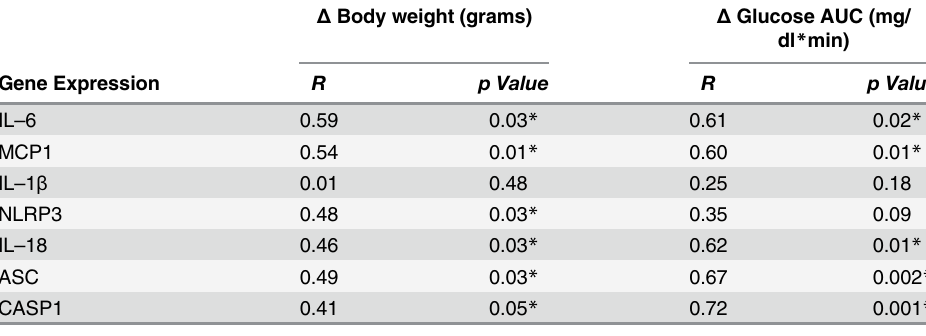
* Threshold of signi fi cance set at P < 0.05